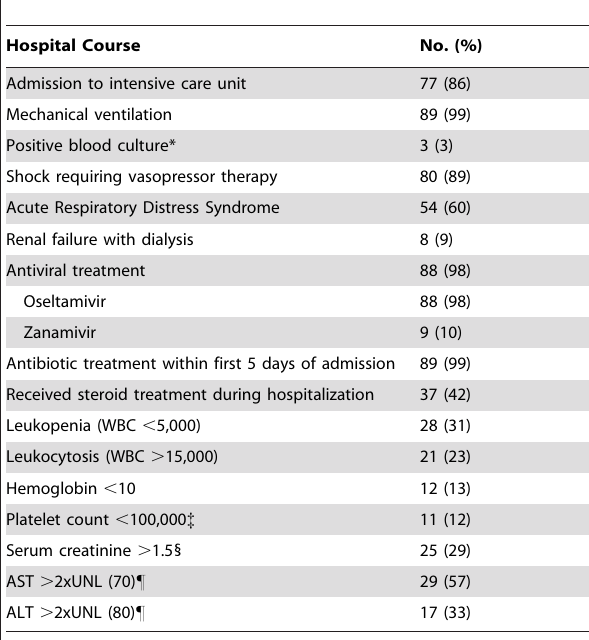
Table 2. Hospital course of 90 influenza A (H1N1)pdm09 virus-associated pneumonia deaths in Thailand for whom medical record reviews were conducted, May 2009-January